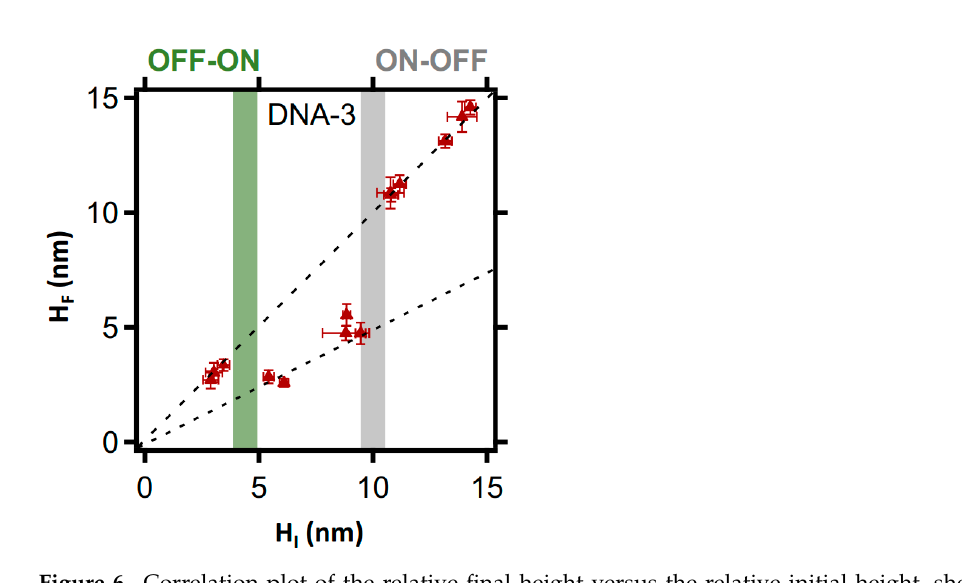
Figure 5. Correlation plots of the relative final height versus the relative initial height, showing the general sequence-density dependence of BamHI action. The plots also show ON-OFF (grey bars) and OFF-ON (green bars) thresholds, indicating the density range where the action of BamHI is ON and the density ranges where it is OFF. The plots in ( a – c ) highlight the behaviour of BamHI in in LCDMs, made up of DNA-1, DNA-2, and DNA-3, respectively.